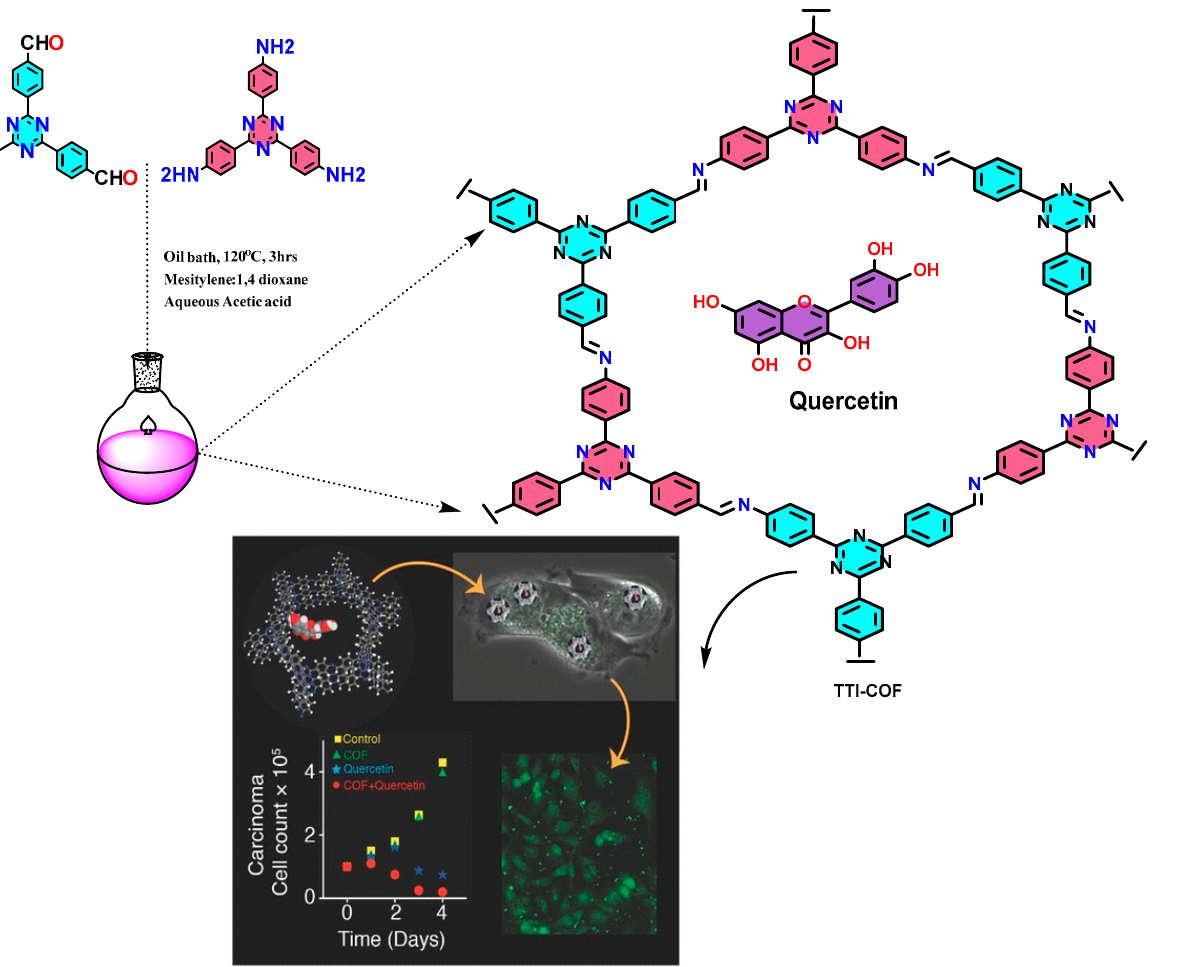
Figure 3. Graphical synthesis representation of imine-linked TTI-COF tagged with quercetin for cancer treatment [11].